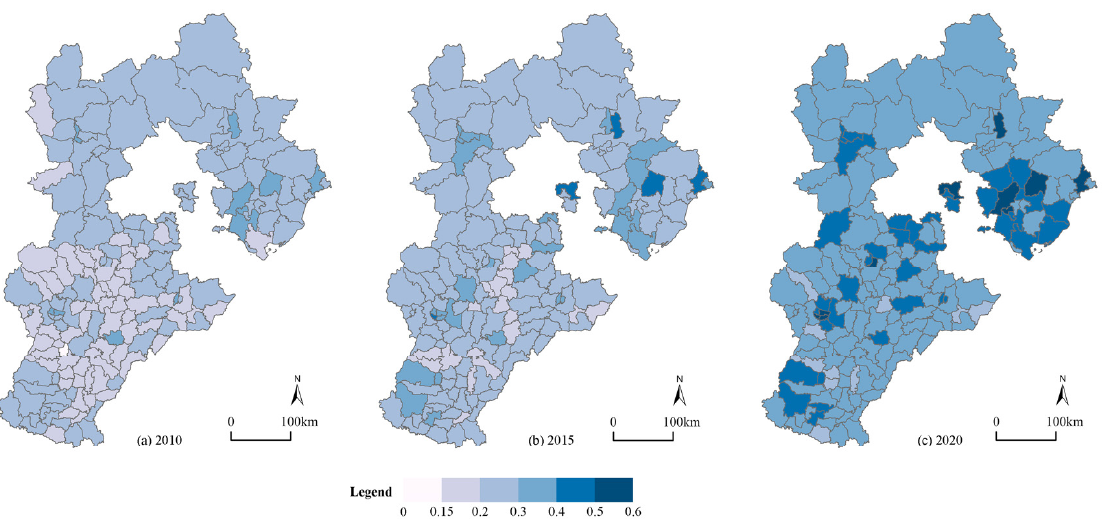
Figure 4. Spatial distribution of the urban resilience of 167 counties in Hebei. ( a ) Urban resilience in 2010; ( b ) urban resilience in 2015; ( c ) urban resilience in 2020.